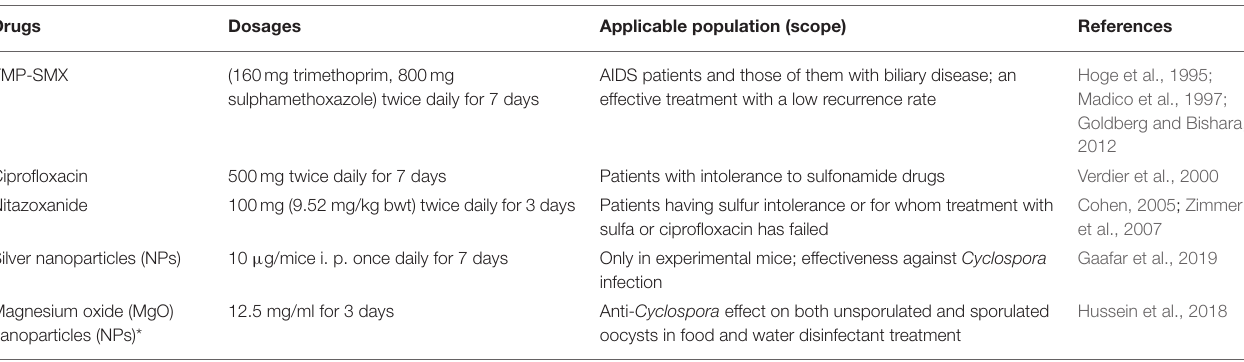
TABLE 2 | Anti- Cyclospora oocyst